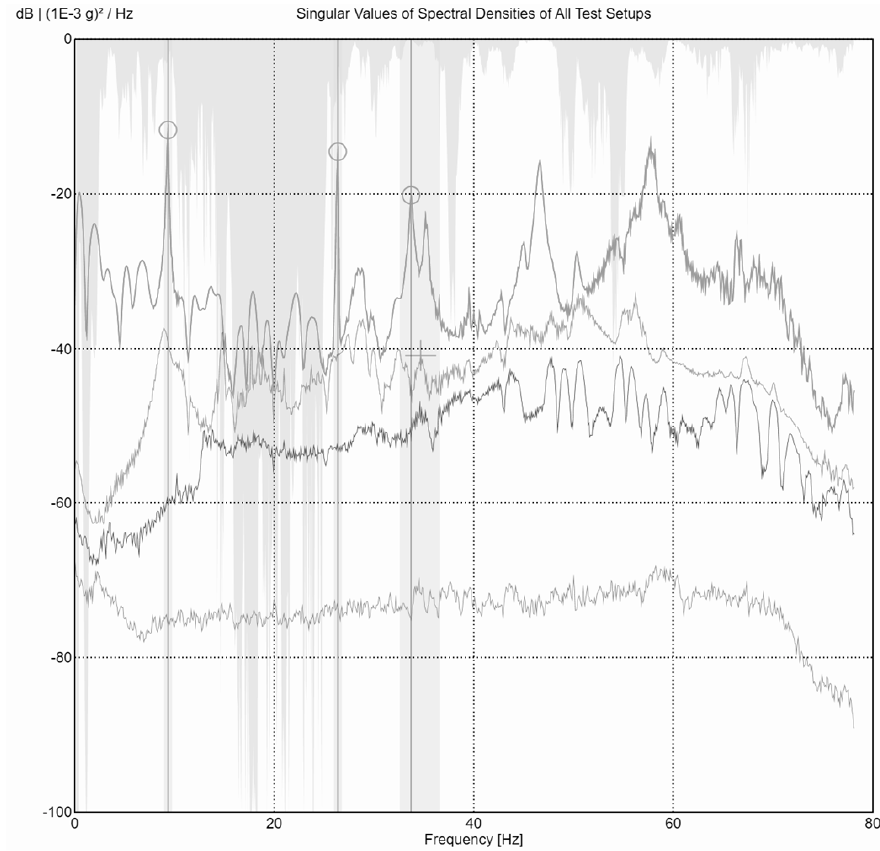
Figure 8. Singular value plots from the FDD analysis.